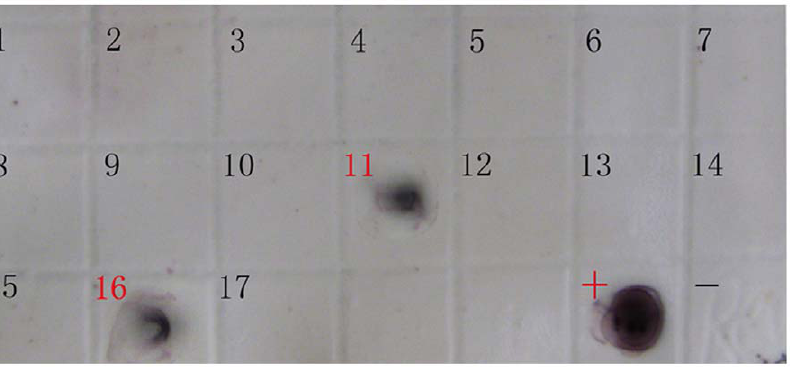
Figure 2. Detection of REV env gene from CEFs inoculated with vaccines. Dot 1–17: DNAs from CEFs respectively inoculated with ND-B1 vaccine, REO-1133 vaccine, FP vaccine, ND-LaSota vaccine, IBD-B87 1 vaccine, IBD-B87 2 vaccine, ND-CS2 1 vaccine, ND-CS2 2 vaccine, ND-LaSota + IBD- H52 vaccine, REO-1133 vaccine, MD-CVI988/Rispens vaccine, ND-CS2 vaccine, ILT-A96 1 vaccine, ILT-A96 2 vaccine, FP + AE-1143 vaccine, ND-LaSota + IB- H120 vaccine, and MG-F vaccine; dot + : DNA from CEF inoculated with strain SNV of REV; dot -: no DNA. The red numbers represent the positive results.